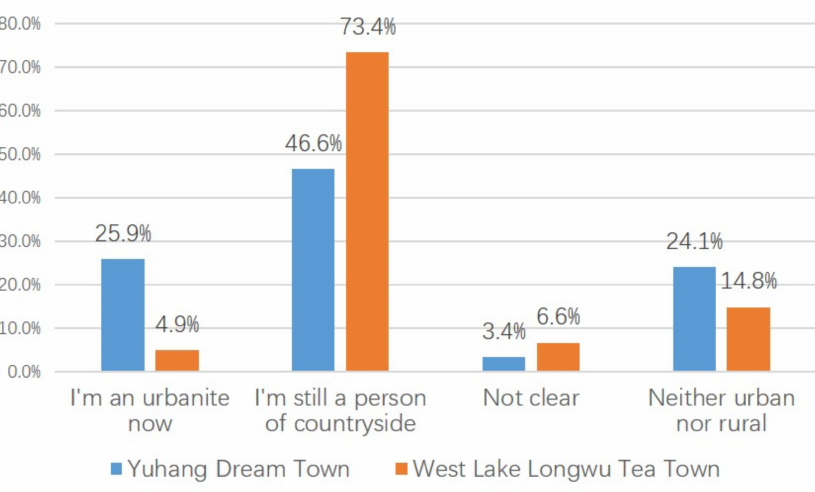
Figure 28. Changes in respondents’ personal identities awareness after the local CT practice (source: